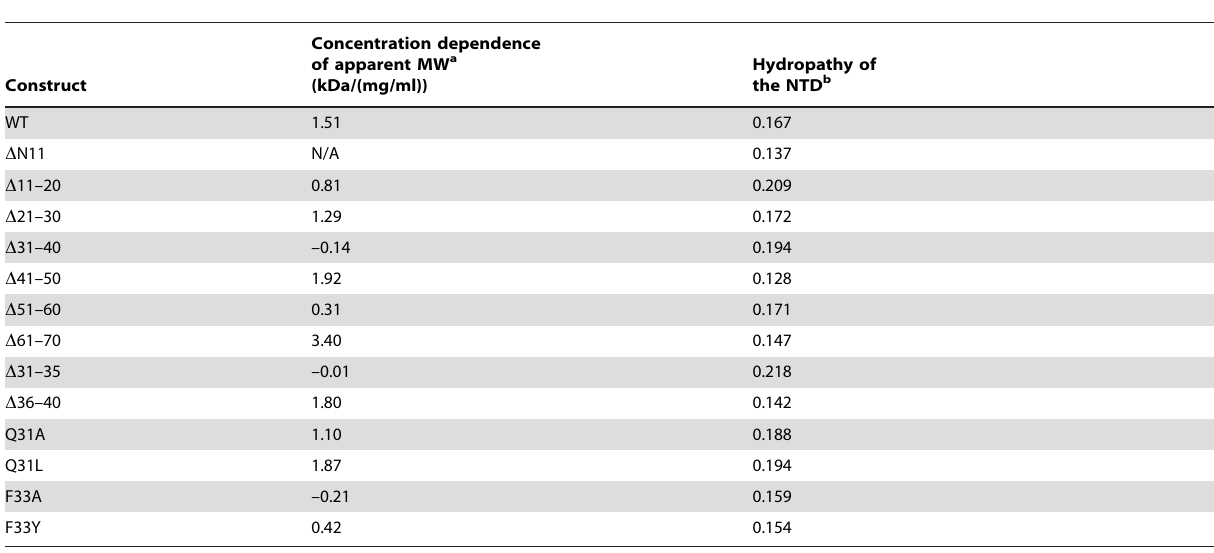
Table 1. Biophysical properties of wild-type HSPB6 and its